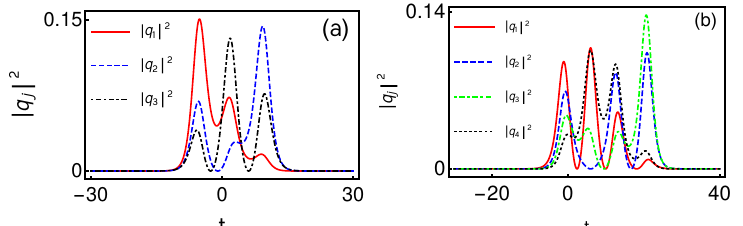
Figure 8. ( a ) Denotes triple-hump profile of the nondegenerate fundamental soliton in the 3-CNLS system and ( b ) represents a quadruple-humped nondegenerate soliton profiles in the 4-CNLS system.